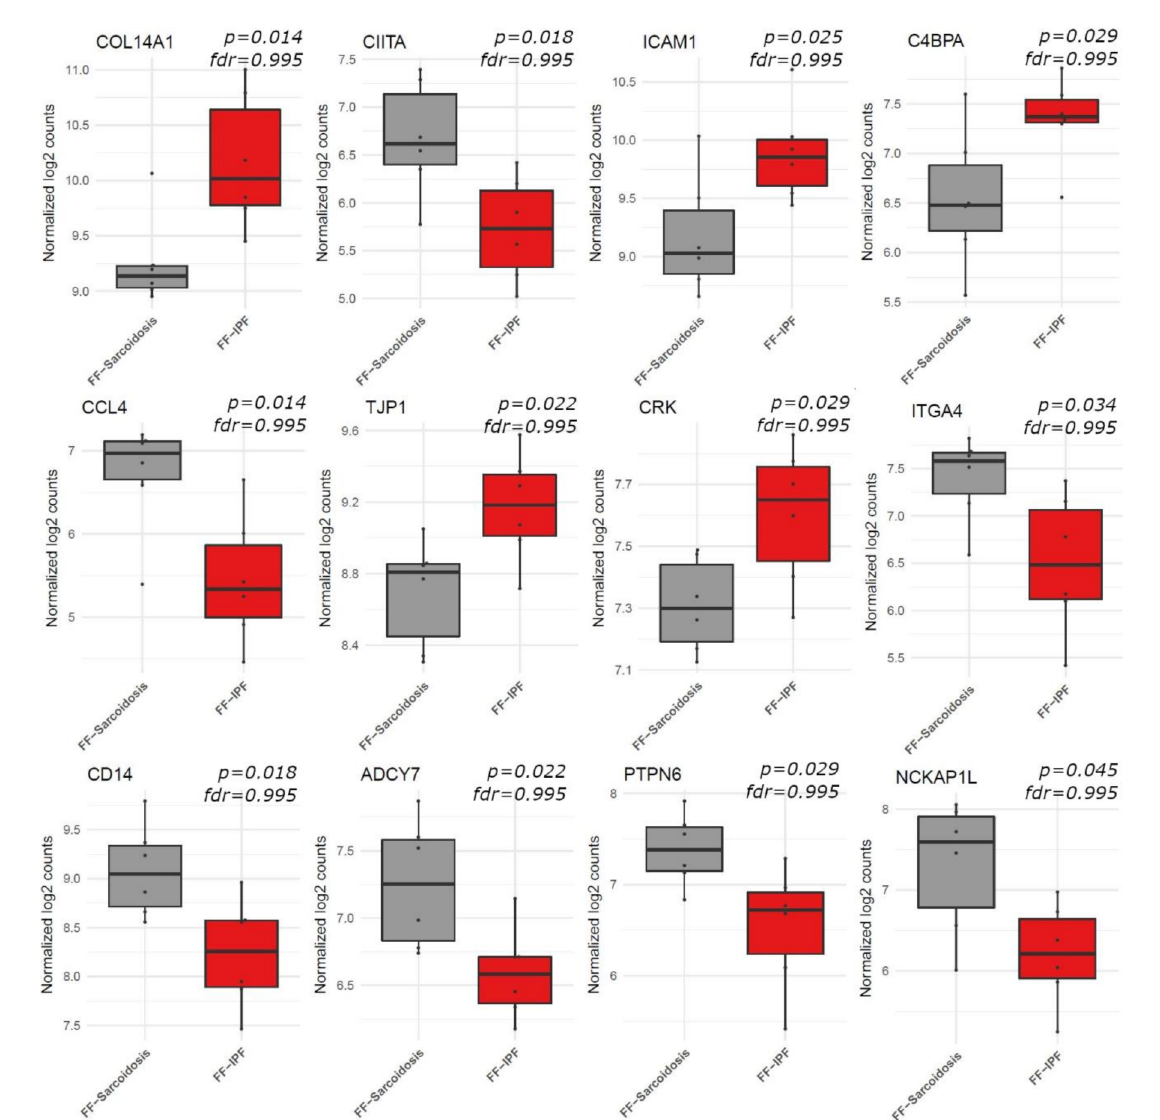
Figure 3. Gene expression—sarcoidosis vs. IPF. This figure shows the top 12 regulated genes between sarcoidosis and idiopathic pulmonary fibrosis (IPF) in box-plots. FF, fibroblastic foci; IPF, idiopathic pulmonary fibrosis; fdr , false discovery